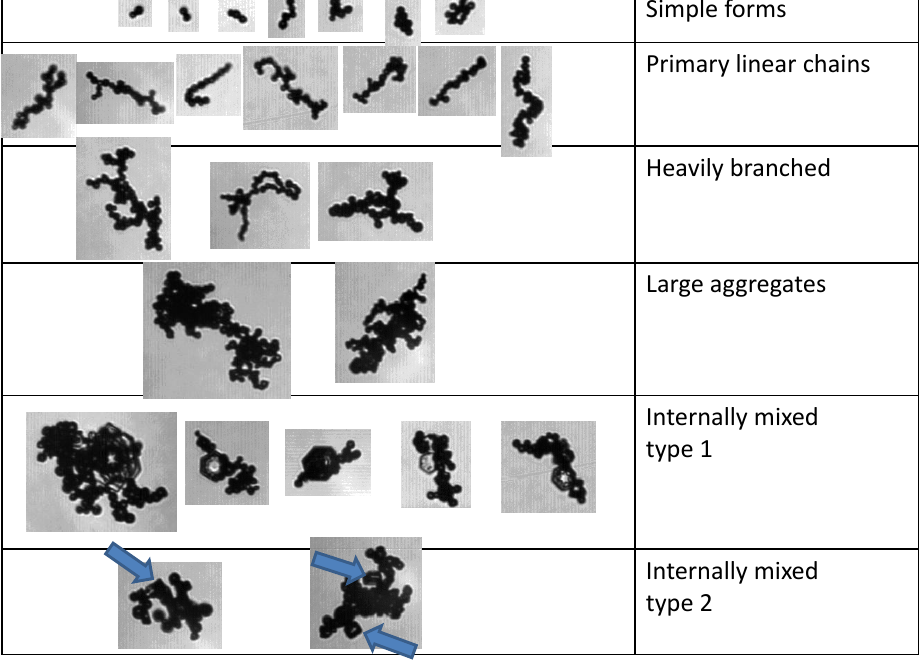
Fig. 14. Examples of different forms of FDAs. Arrows point to examples of faceted crystals found in the matrix of frozen drops. See text for further explanation. Table 1. Regions where FDAs were found during the DC3